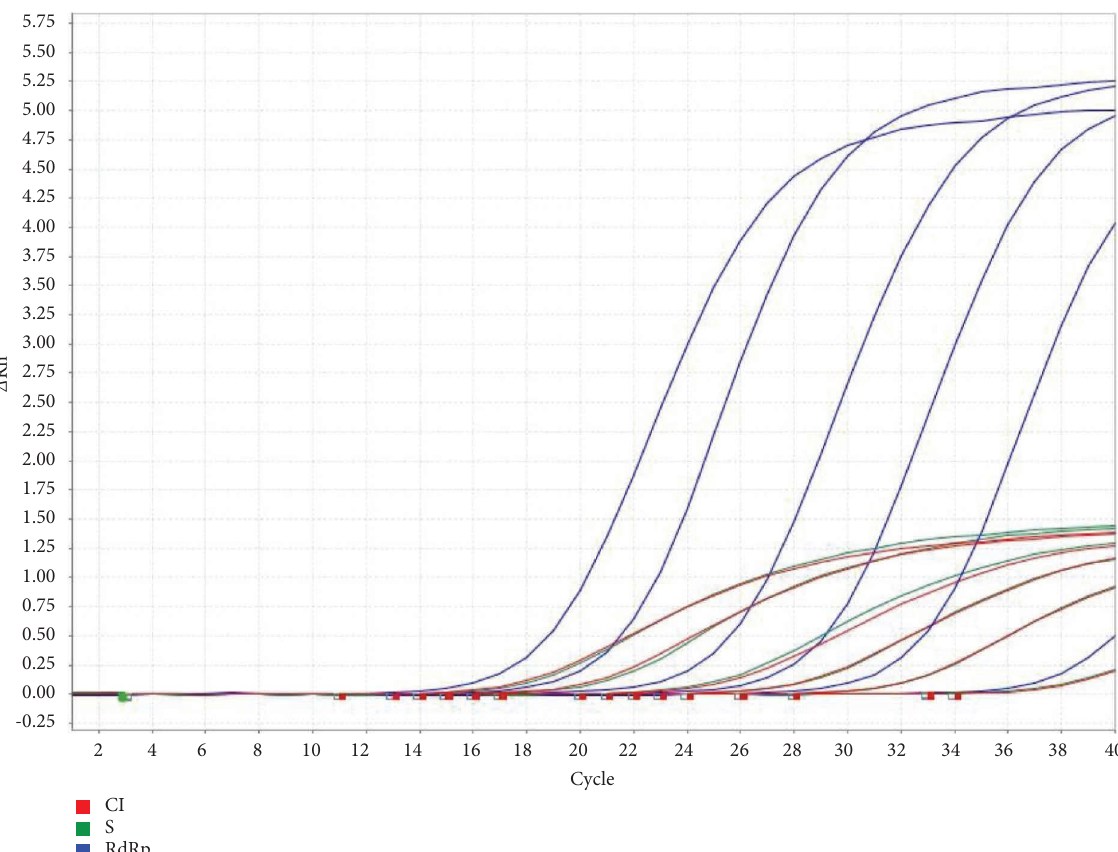
Figure 2: Analytical sensitivity test result of the MAScIR SARS-CoV-2 M 2.0 kit. Target S, green; target RdRp, blue; IC, red. Table 3: Results of the fve EQA (expected results and our laboratory results) (BIOER extractor, QS5 thermal cycler). WHO-SC 20-01